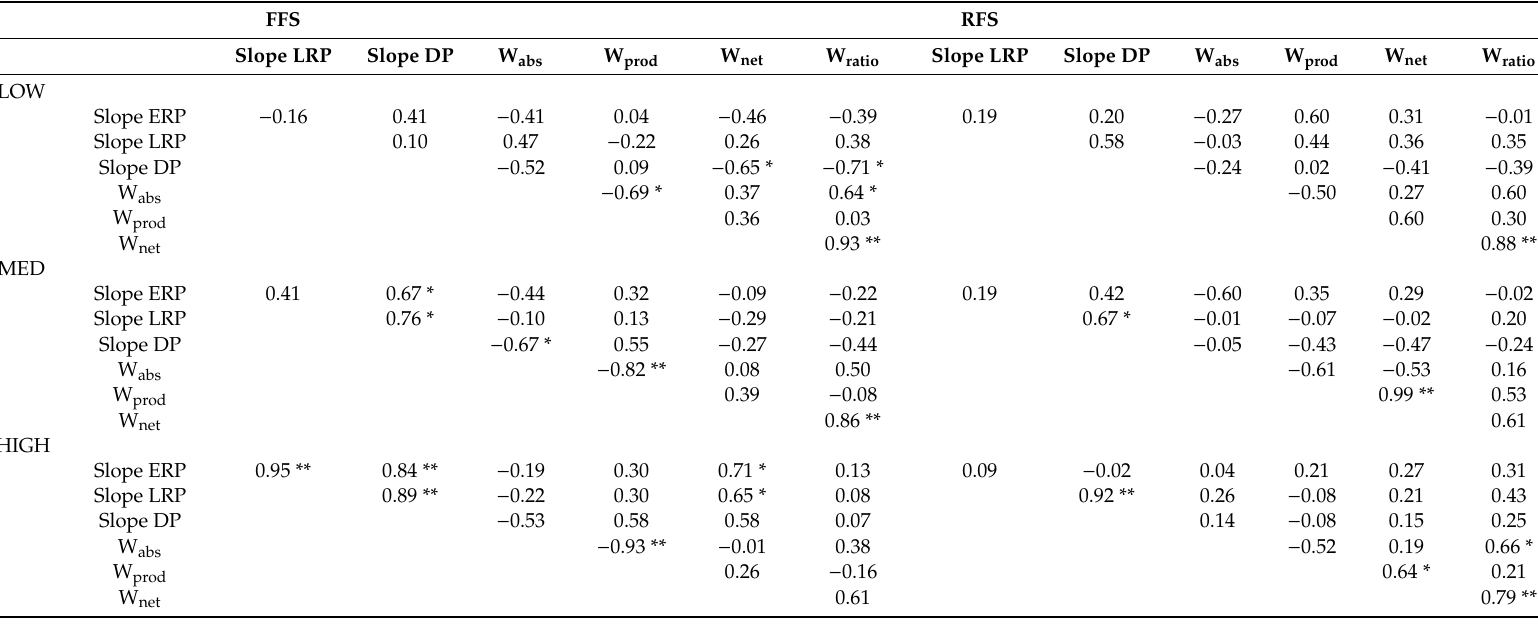
Table 1. Correlations between moment–angle loop parameters (Spearman correlation coe ffi cient rs). * represents statistically significant correlations ( p < 0.05); ** represents statistically significant correlations ( p < 0.01). W abs : work absorbed. W net : net work. W prod : work produced. W ratio : work